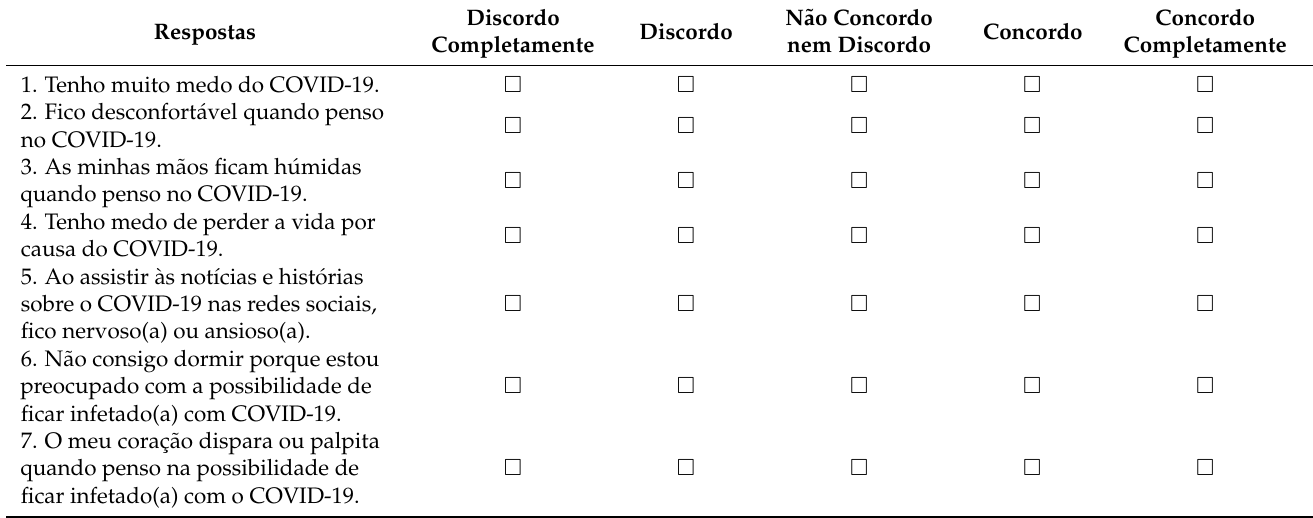
Table A2. Items of the Fear of COVID-19 Scale (Portuguese version).